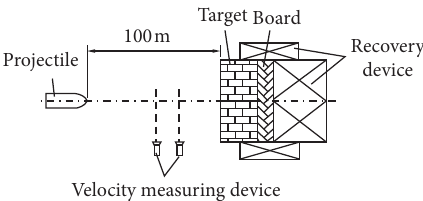
Figure 11: Experiment device installation.